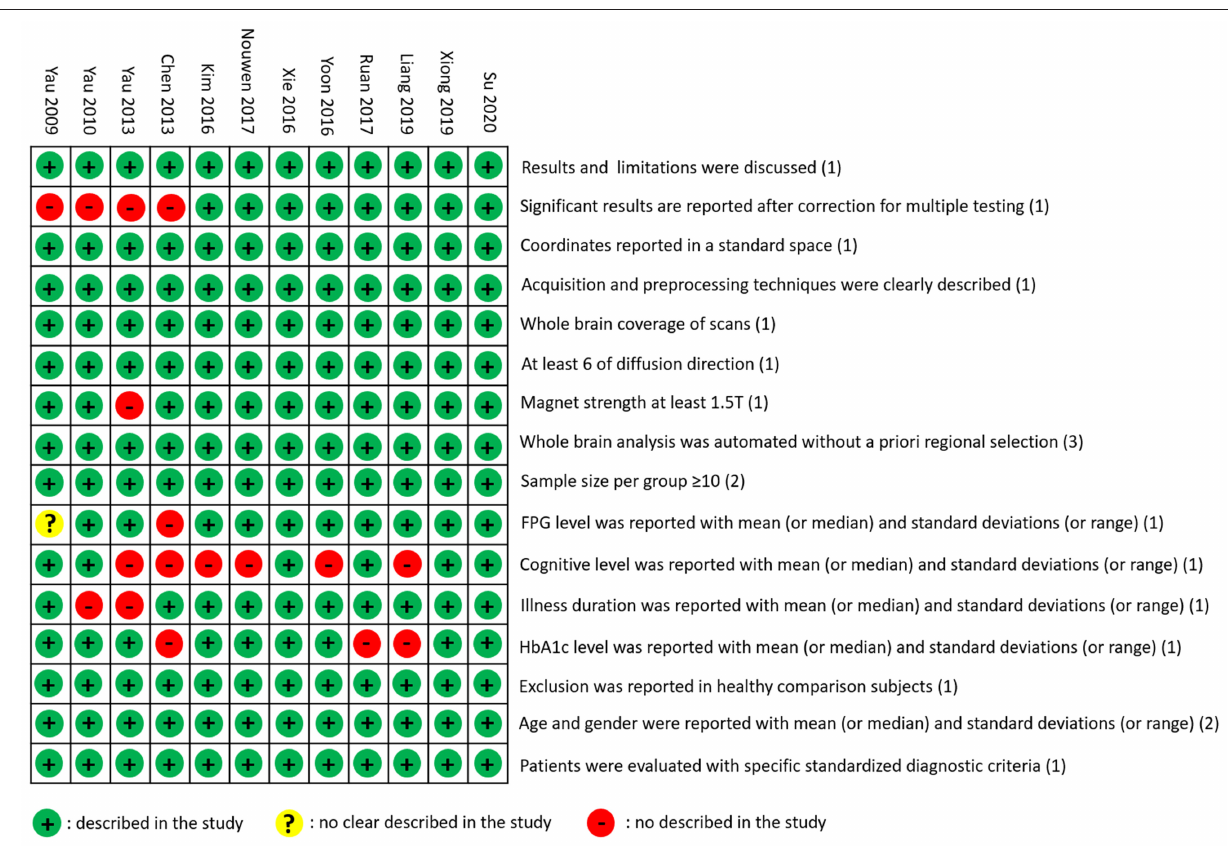
the posterior cingulate cortex is involved in the adjustment of working memory, visual space, and spatial orientation. In particular, the anterior cingulate cortex plays a key role in